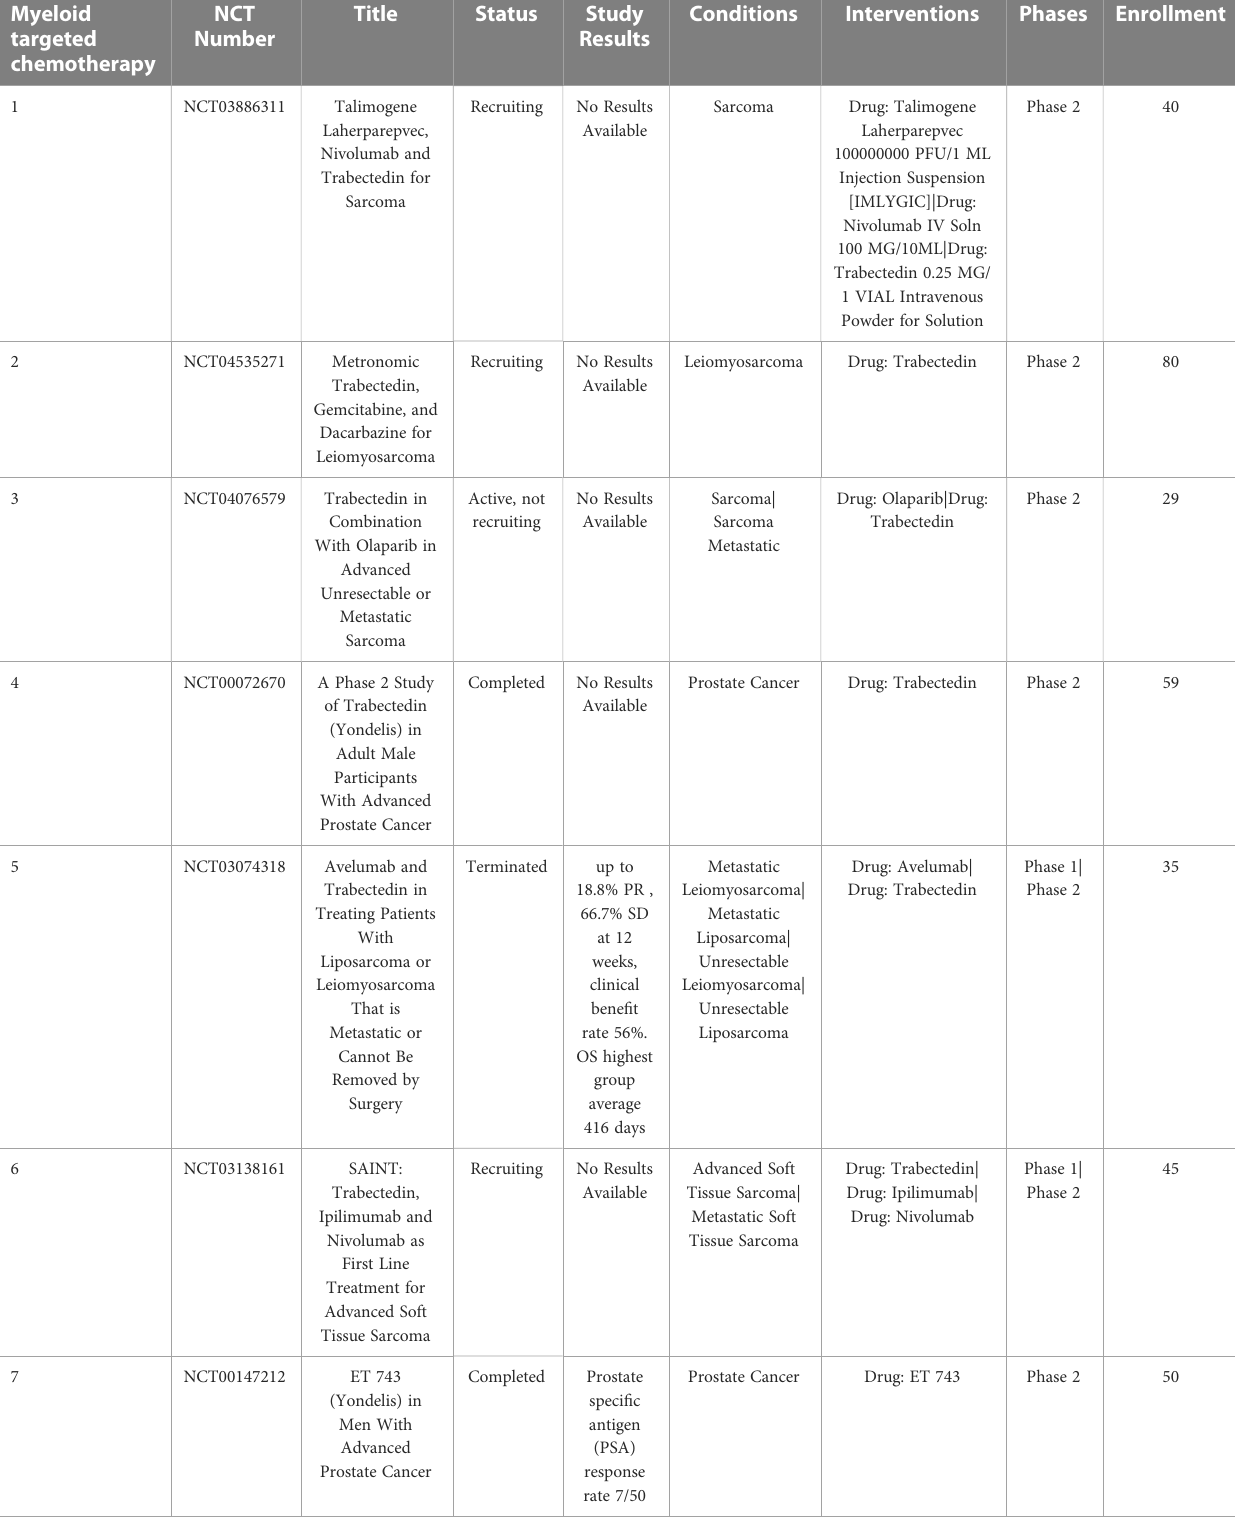
TABLE 3 US clinical trials using Trabectedin as myeloid cell depleting chemotherapy for cancer. Myeloid targeted